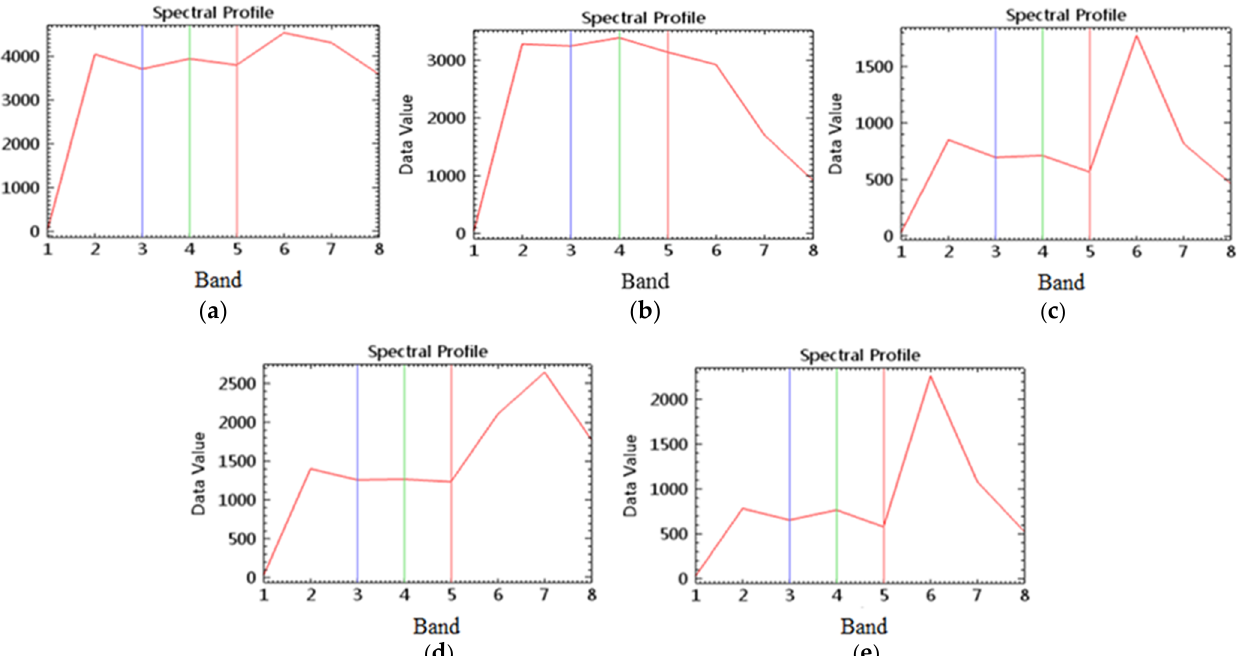
Figure 11. The spectral profile of different objects. ( a ) The profile of cloud on area 1; ( b ) The profile of heavy smoke on area 2; ( c ) The profile of thin smoke over the area 3; ( d ) The profile of thin smoke over the area 4; ( e ) The profile of smoke over the hot spot (the fire point) on area 5.